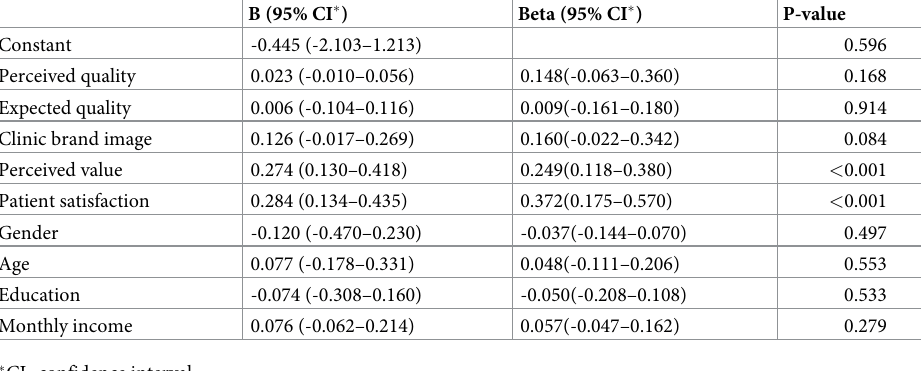
Table 3. Multiple linear regression model of patient loyalty in the private dental clinics (n = 125).